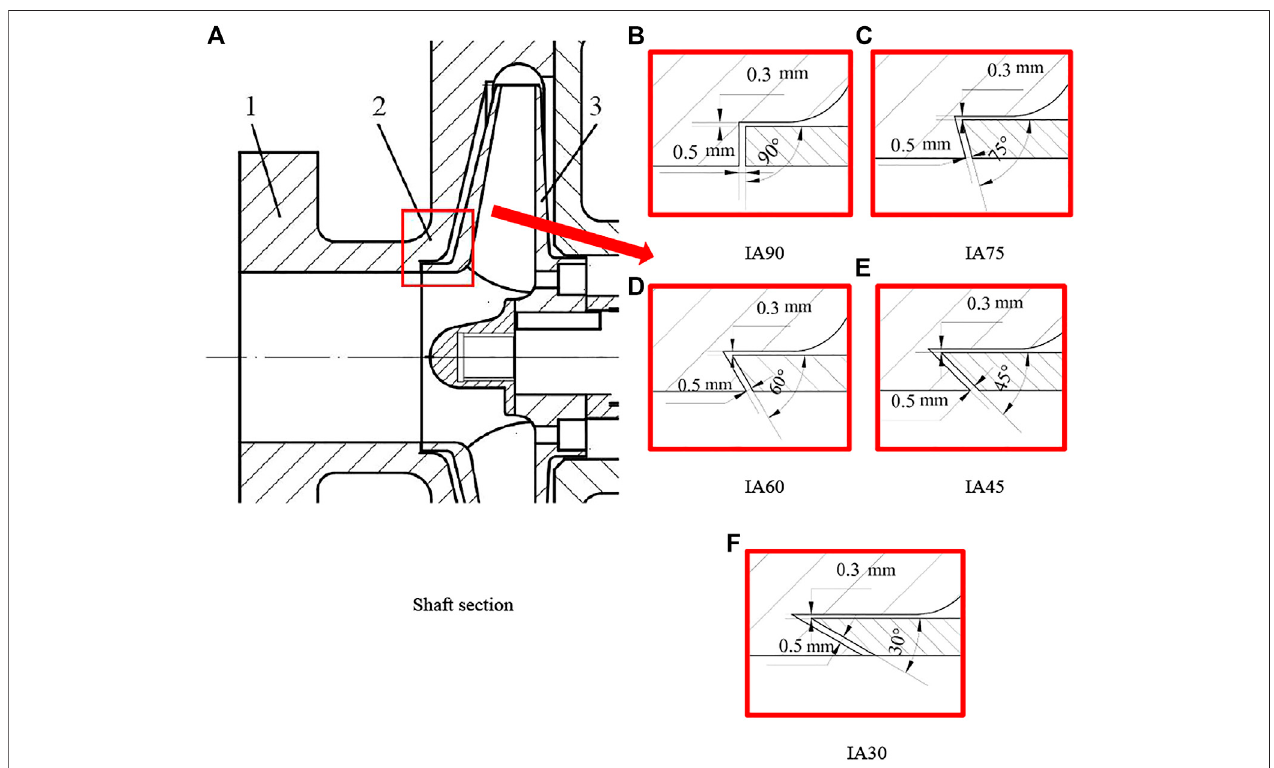
FIGURE 2 | Diagram of incident angle of different wear-ring clearances.